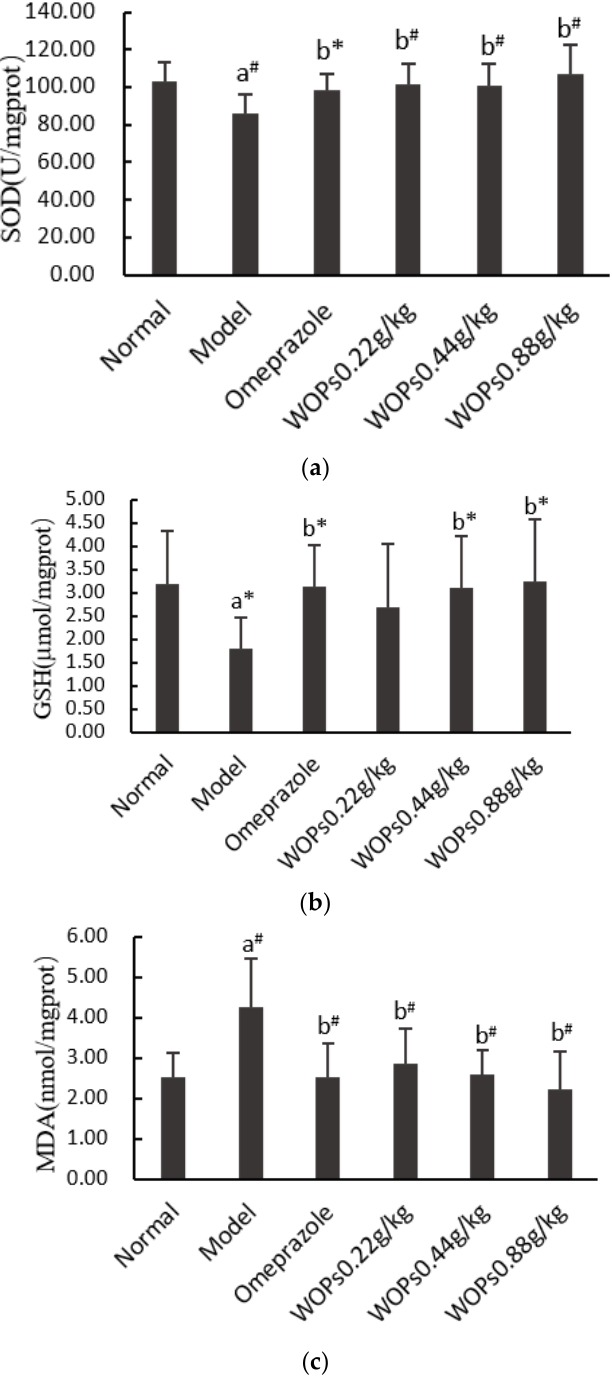
Figure 5. E ff ects of WOPs on SOD ( a ), GSH ( b ), MDA ( c ) levels in indomethacin-treated rats. Signif- icance was represented as * p < 0.05, # p < 0.01; a—compared with normal group, b—compared with model group; 10 per group. SOD—superoxide dismutase; GSH—reduced glutathione; MDA— malondialdehyde; WOPs—walnut